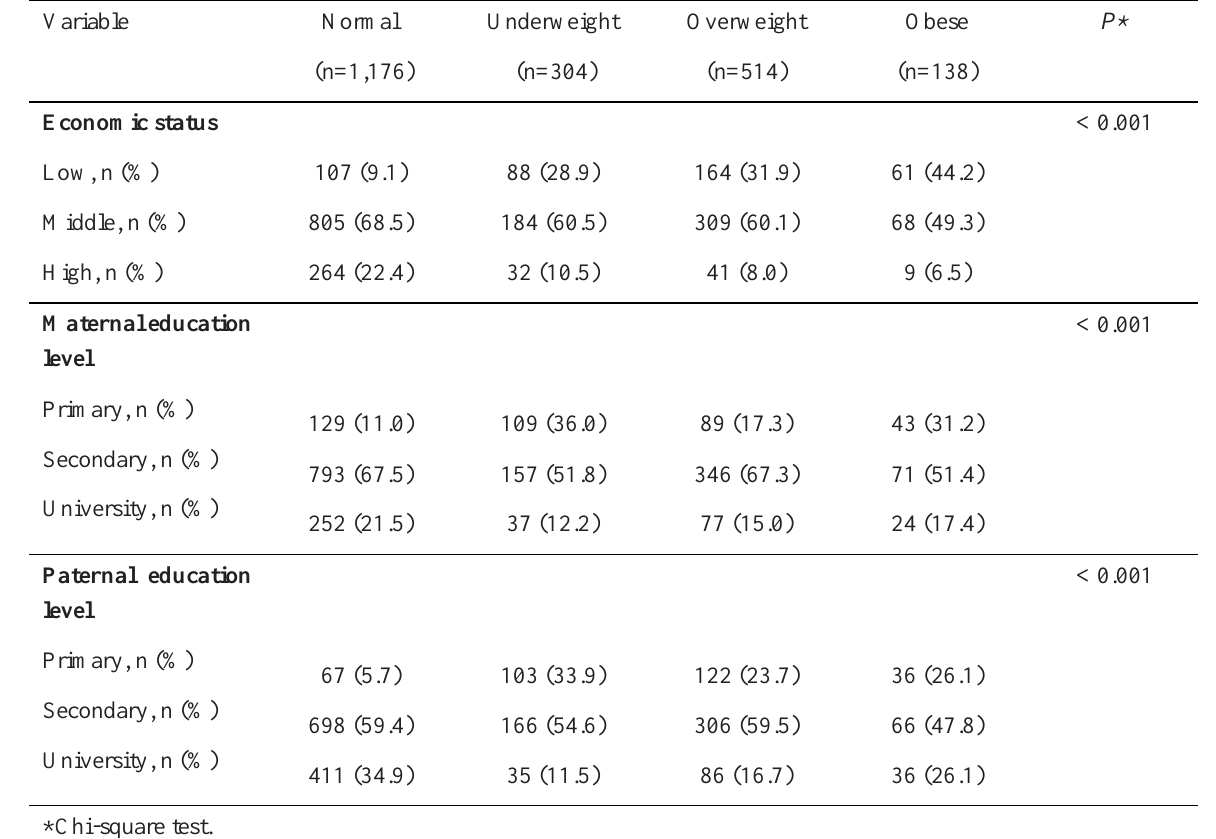
Table 3. Comparison of the socioeconomic variables in the participants in BMI groups and obesity in our study may be attributed to the differences in sample size, socioeconomic status, physical activity level, or eating habits. In another study between 2,900 students (1,200 males and 1,700 females) aged 11-17 years in Tehran (2004-2005), prevalence of overweight and obesity were 17.9 and